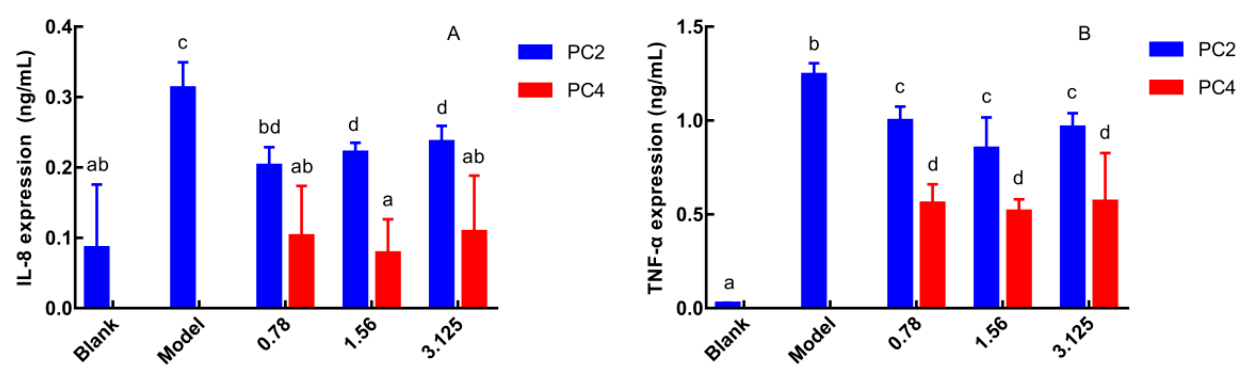
Figure 2. Effects of 6-hydroxy-2,4,7-trimethoxyphenanthrene (PC2) and 6,7-dihydroxy-2,4-di methoxy-phenanthrene (PC4) on the expression of inflammatory factors ( A ) Expression of interleukin-8 (IL-8), ( B ) Expression of tumor necrosis factor- α (TNF- α ). Values without a common letter were significantly different as p < 0.05.